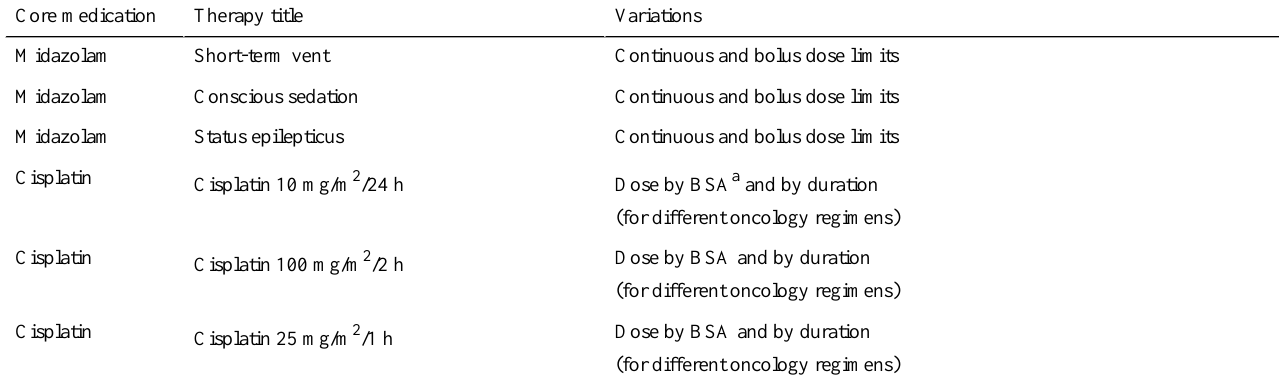
Table 1. Examples of therapies.